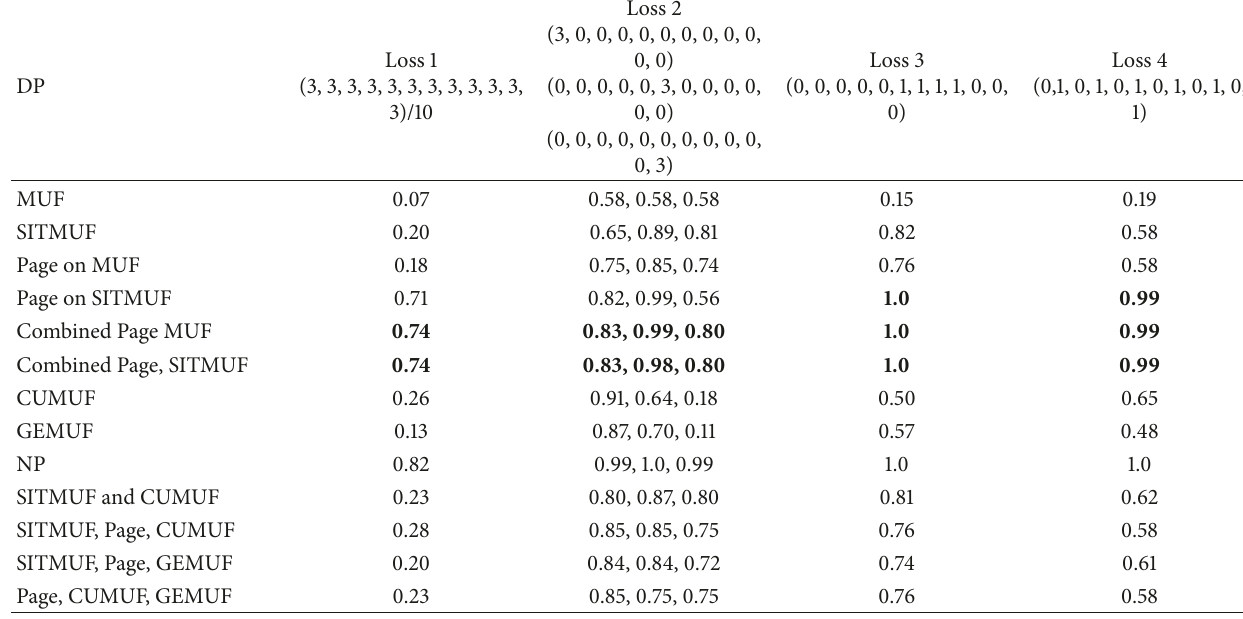
Table 1: DPs for Σ 1 . Boldface entries have the largest DPs (excluding NP) for the respective column.